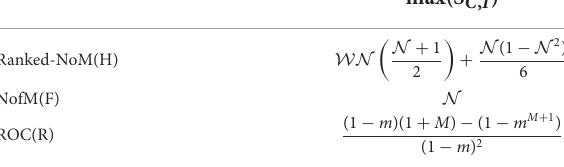
TABLE 1 Formulas for the maximum value of integration S C , I for each